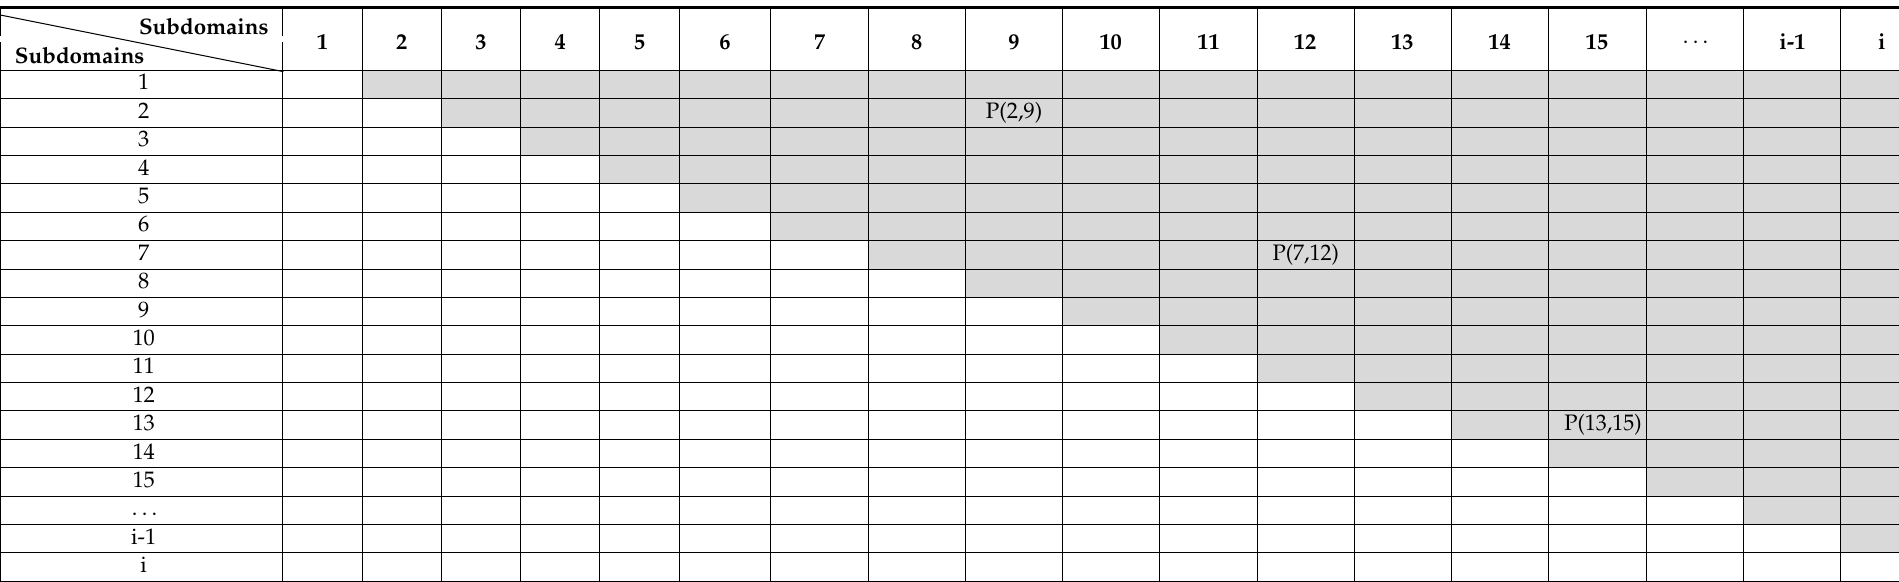
Table 6. Intersection Triangular Top Matrix (ITTM) (To show that the algorithm only deals with upper side of the matrix which is highlighted in grey color).